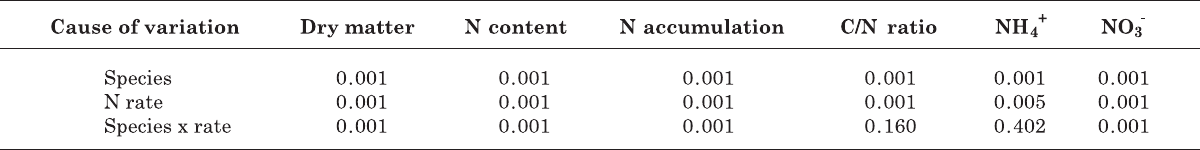
Table 1. Significance levels (F test) for shoot dry matter, N contents, N accumulation, C/N ratio, NH 4+ and - washed from the straw of different cover grasses as related to N NO 3